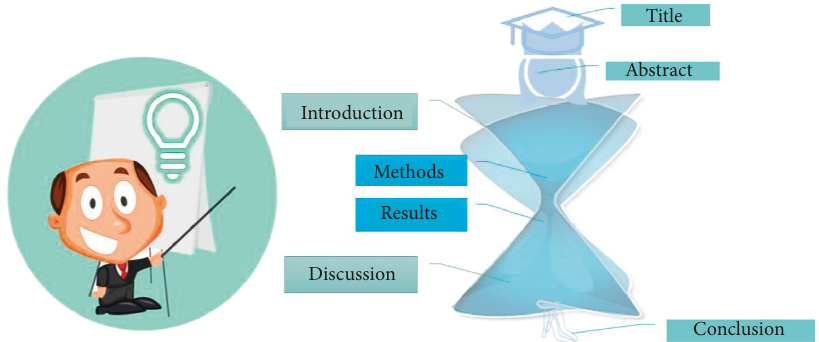
Figure 2: Generalized anatomy of manuscript based on IMRAD format.